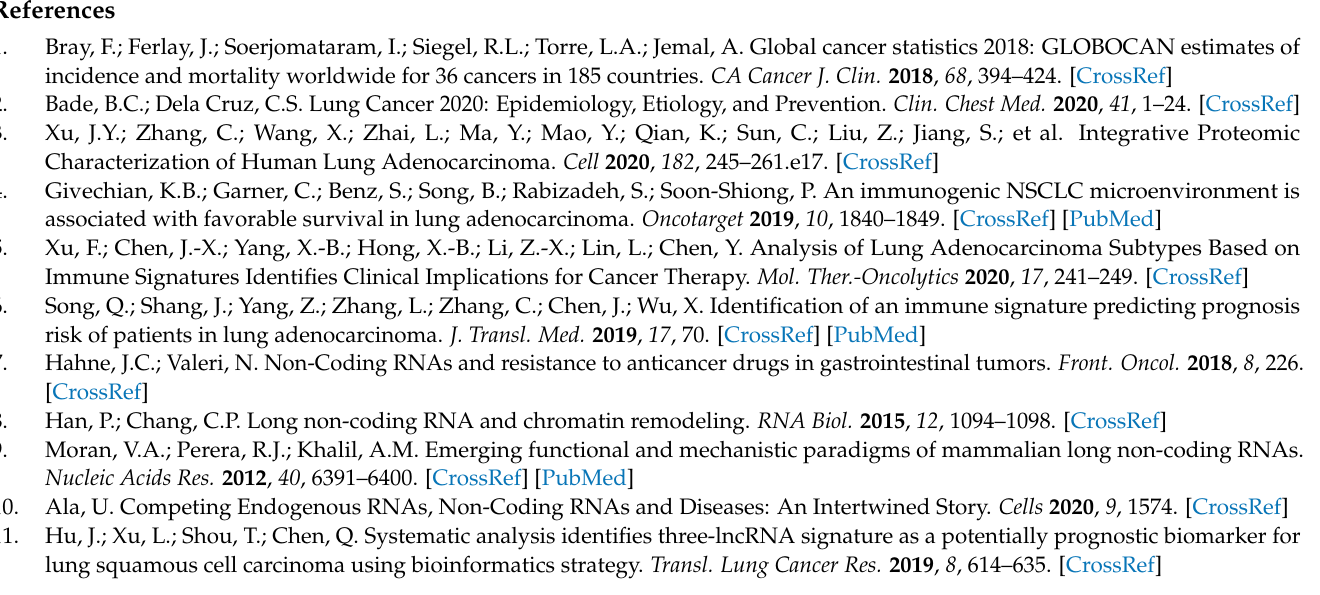
Table S3. Univariate and multivariate analysis (Cox regression model) of WT1-AS and IGF2BP2 in LUAD patients; Table S4. Correlation analysis between IGF2BP2 and biomarkers of immune cells using TIMER; Figure S1. Expression distribution expression of c-Myc in various cancer tissues; Figure S2. Correlation analysis of differentially expressed RNAs in ceRNA network with overall survival of LUAD patients; Figure S3. The distribution of 15 RNAs expression value from the ceRNA network in the TCGA LUAD dataset; Figure S4. The distribution of 15 RNAs expression value in 57 (46) paired LUAD tissues; Figure S5. Correlation analysis of IGF2BP2 expression levels with immune infiltration in lung adenocarcinoma. (A) Correlation between IGF2BP2 gene copy numbers and the level of infiltration of six immune cells in LUAD. (B) Correlation between IGF2BP2 expression and the level of immune infiltration in LUAD. (C) Correlation analysis of immune infiltration and OS